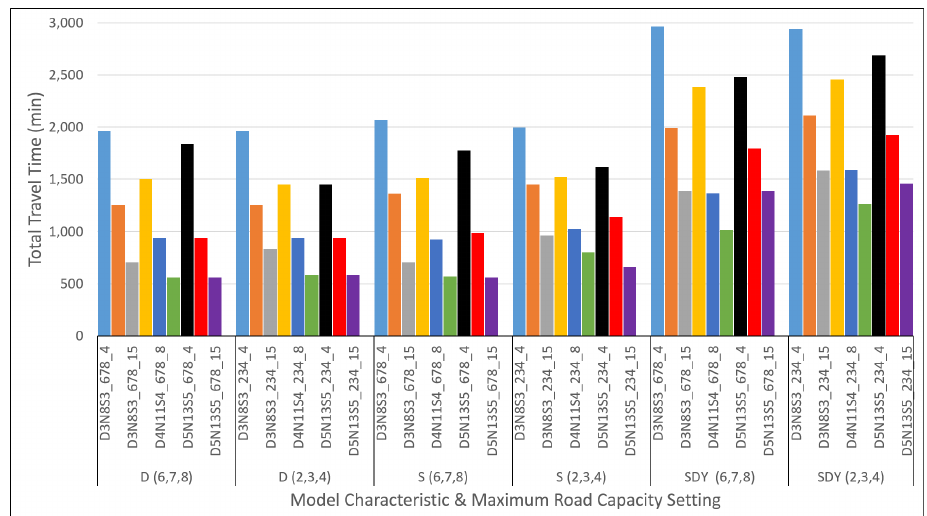
Figure A21. Total Travel Time in Online and Offline Computation for all Instances grouped by Model Characteristic and Maximum Road Capacity Setting.